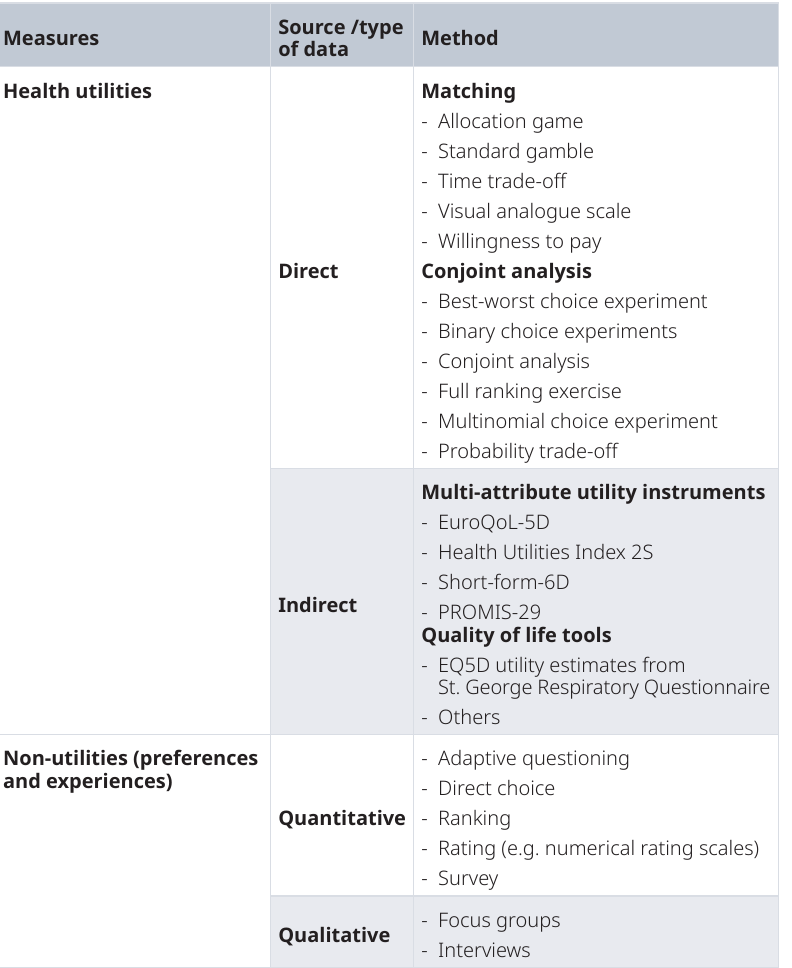
Table 1. Methods to ascertain values and